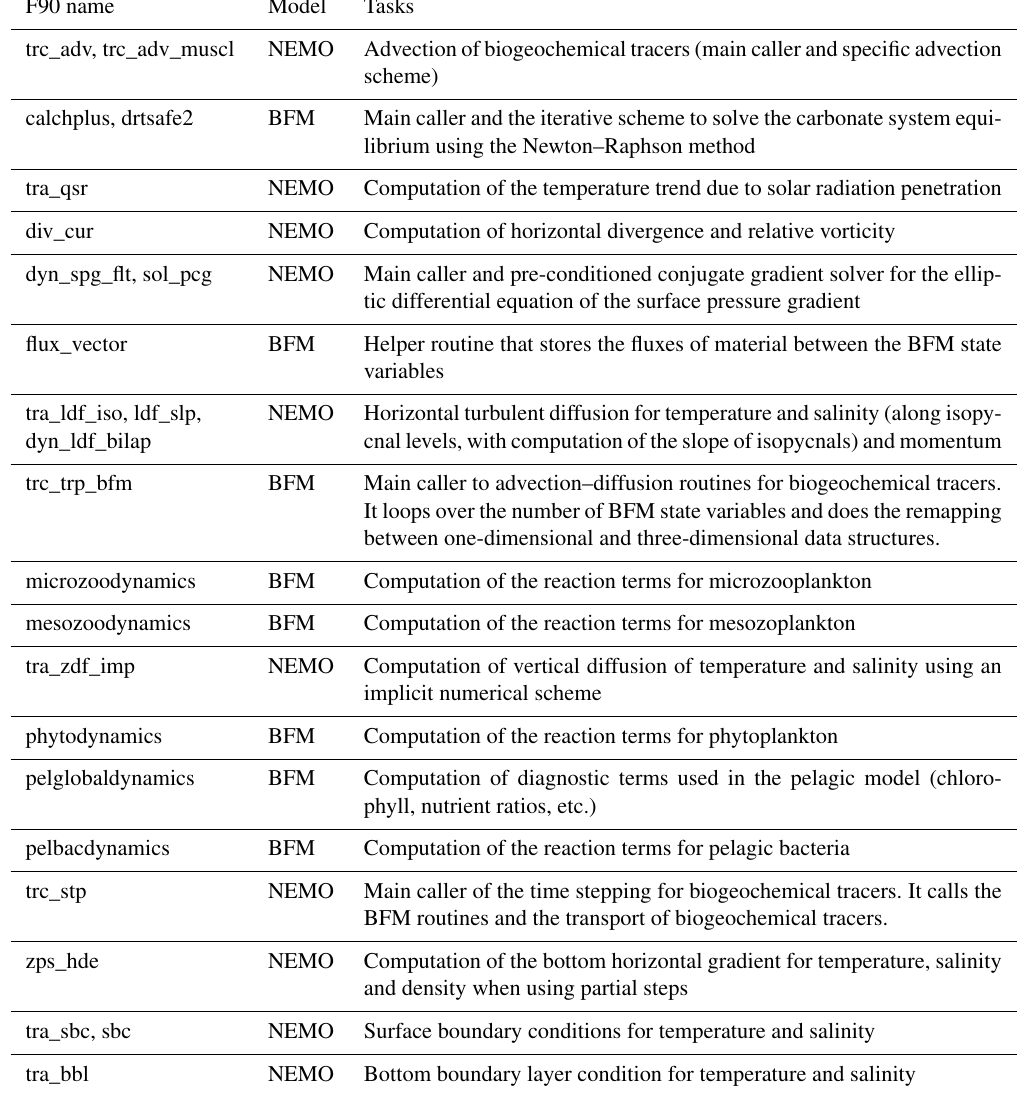
Table 4. Name and description of the routines selected during the code profiling analyses. The routines identified as belonging to the BFM are also the ones that originate from NEMO, but they have been modified for the BFM memory